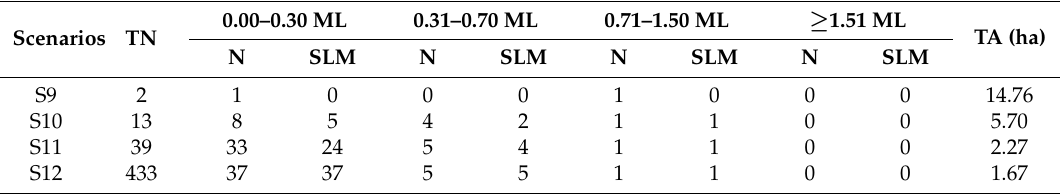
Figure 16. Distribution of overflow junctions and flood area, flood volume of the overflow junctions, and flood depth of the flood subcatchments for the main district. Table 5. The total number of overflow points (TN), the number of overflow points (N), the same number of overflow point locations compared with the control group (SLM), and the total inundated area (TA) of Scenarios S9–S12 for the northern district.